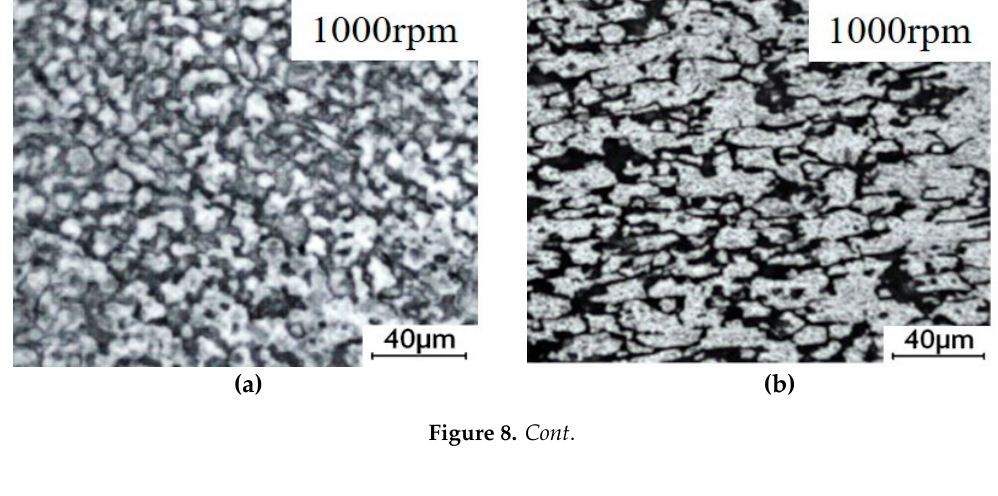
Figure 7. The microstructure of the steel of the keyhole-free FSSW joint: ( a ) weld nugget zone (WNZ), ( b ) thermo-mechanically affected zone (TMAZ), ( c ) heat-affected zone (HAZ), and ( d ) base metal (BM).